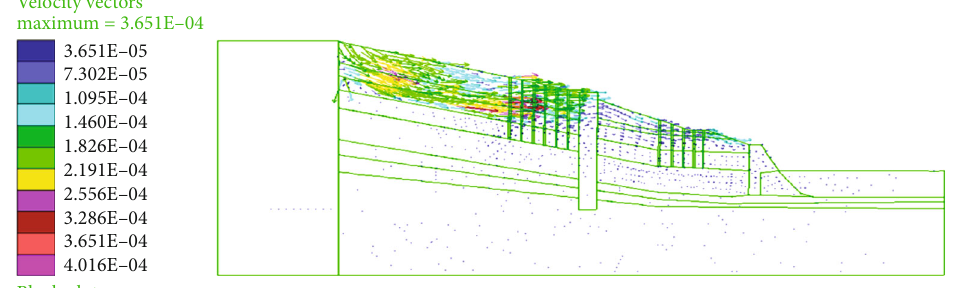
Figure 13: The minimum new FOS and the failure state of velocity